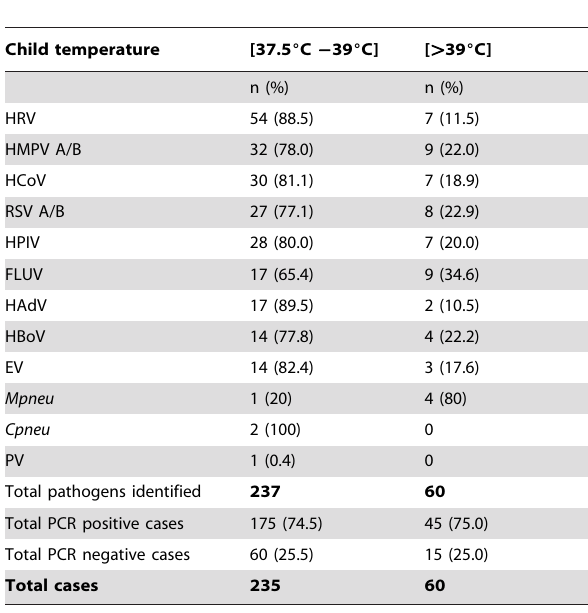
Table 3. Relationship between child temperature and ARI viral and bacterial etiologies.